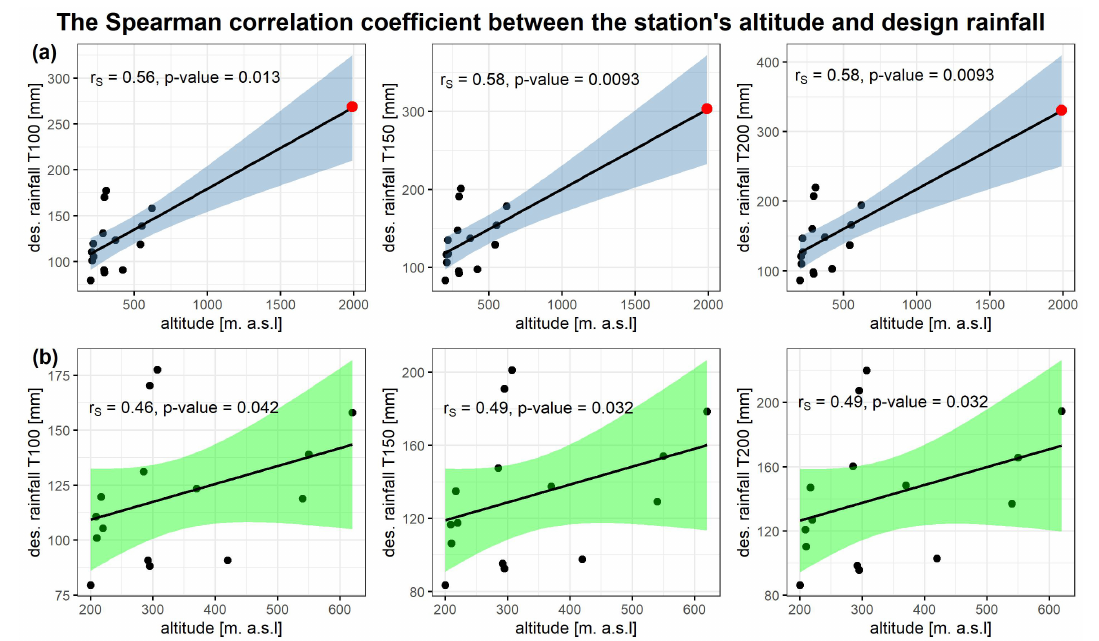
Figure 8. The scatterplot showing the relation between the station’s altitude and design rainfall depth for return periods of 100, 150, and 200 years. ( a ) With the Kasprowy Wierch station (marked in red) ( b ) Without the Kasprowy Wierch station. The blue or green area represents the confidence region around the regression line and its upper and lower bands are confidence limits of the predicted rainfall depths at the confidence level of 95%.